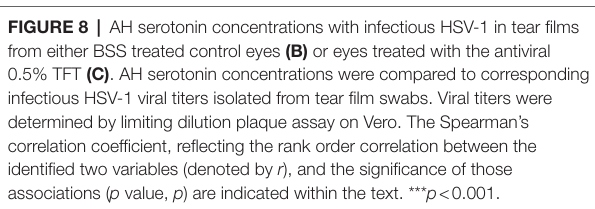
FIGURE 8 | AH serotonin concentrations with infectious HSV-1 in tear films from either BSS treated control eyes (B) or eyes treated with the antiviral